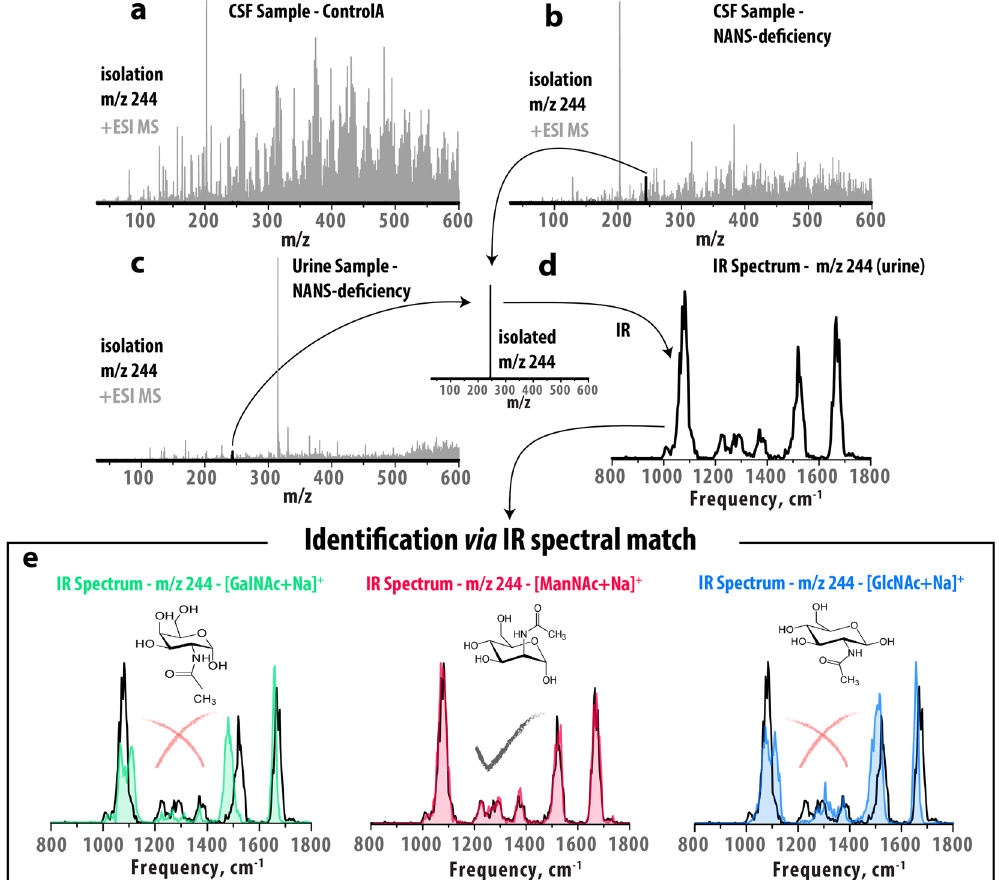
Figure 1. Experimental approach of IR-IS, combining mass spectrometry with infrared spectroscopy for metabolite identification. In panels ( a – c ), grey spectra are full + ESI MS spectra of body fluid samples and black spectra are generated after isolation of ions at m/z 244. Panel ( a ) shows the MS spectrum of a control CSF sample demonstrating the absence of ions corresponding to the m/z value expected for ManNAc ([M + Na] + m/z 244), the targeted biomarker in these experiments. Panels ( b ) and ( c ) contain MS spectra generated from ( b ) a CSF sample and ( c ) a urine sample from a patient having NANS deficiency. Panel ( d ) illustrates the mass isolation of ions at m/z 244, and the subsequent measurement of their IR spectrum in the ion trap (black trace). In panel ( e ), the route to identification is achieved via IR spectral match between the spectrum measured from the patient sample (black in all graphs) and reference spectra generated for the known model compounds of alternative N-acetylhexosamines. The IR spectra serve as structural signatures, in this case providing clear identification of the species at m/z 244 from the patient sample as ManNAc by spectral match with the reference IR spectrum